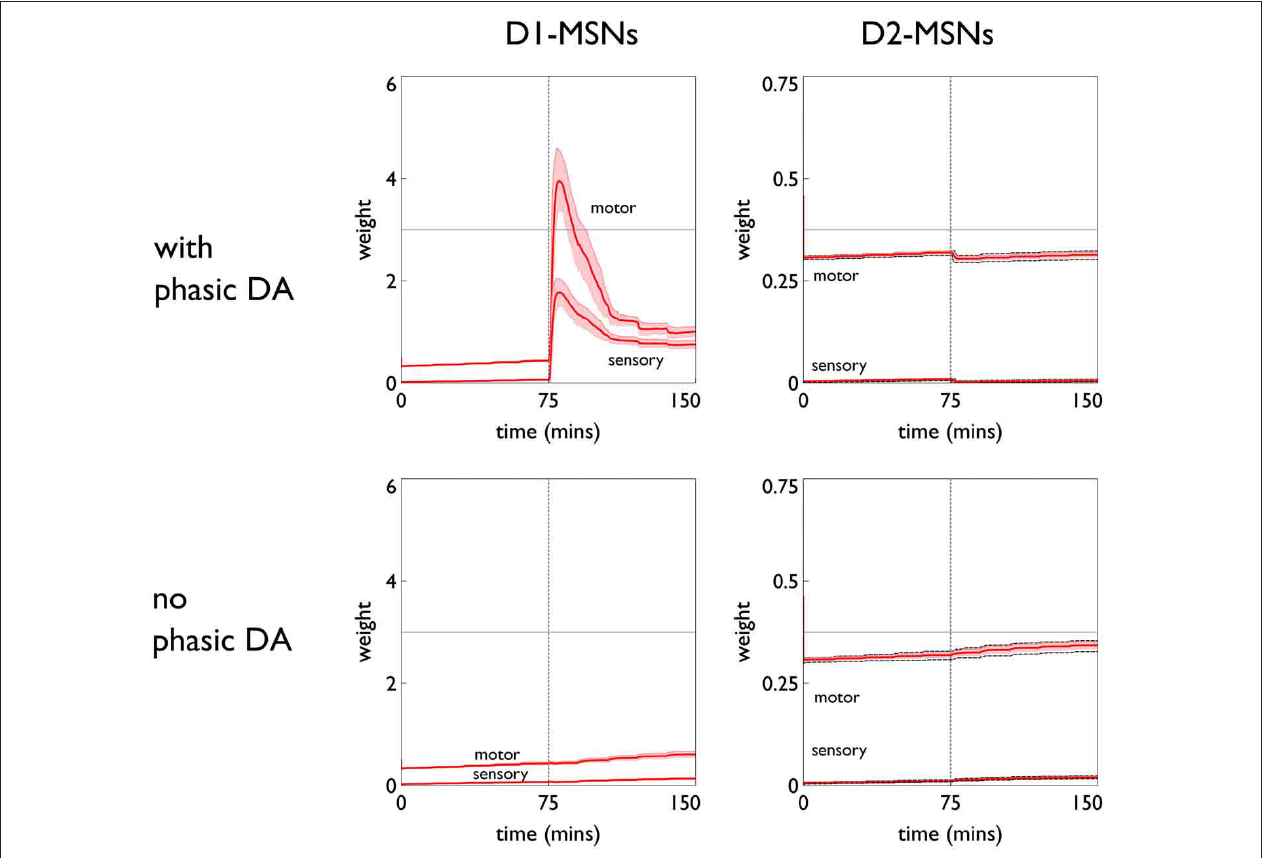
FIGURE 13 | Weight trajectories w * ( t ) for the active response channel, in models with novelty salience and prediction, undergoing fixed-ratio (FR-1) training. All panels have the same significance as their counterparts for variable interval training in Figure 10 . Note the different scale for D1 and